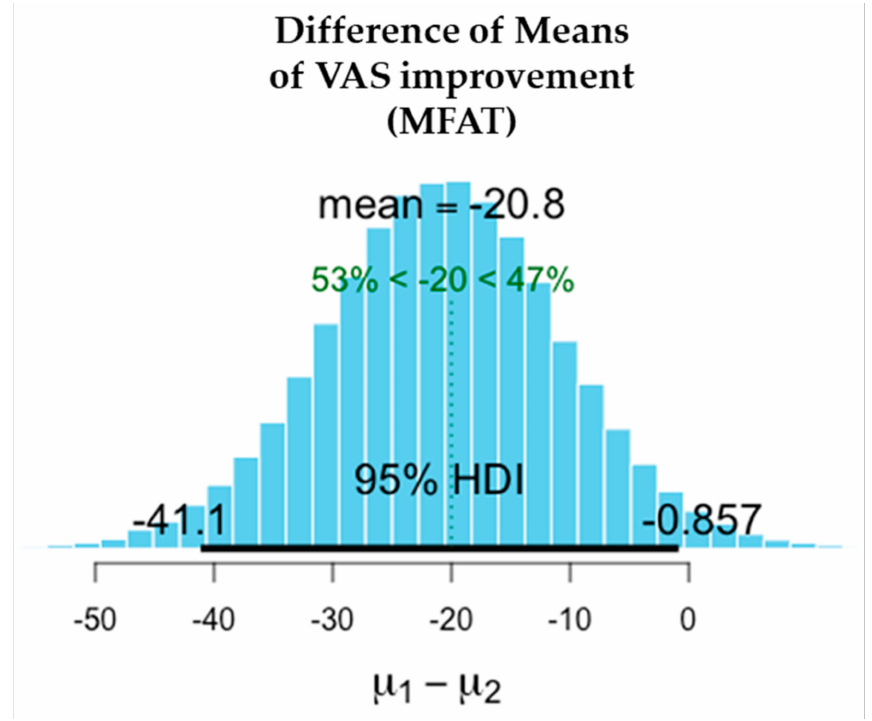
Figure 6. Demonstrates the difference of the means between the pre-treatment ( µ 2 ) and 1 year post treatment ( µ 1 ) VAS for MFAT Only. This shows the 95% credible interval between − 41.117 and − 0.857. The super-responder threshold of − 20 is marked the dotted green line.